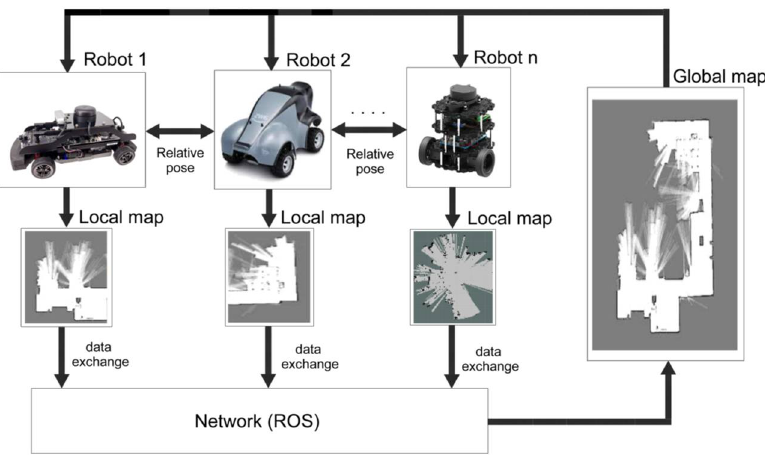
Figure 1. Collaborative simultaneous localization and mapping (SLAM).